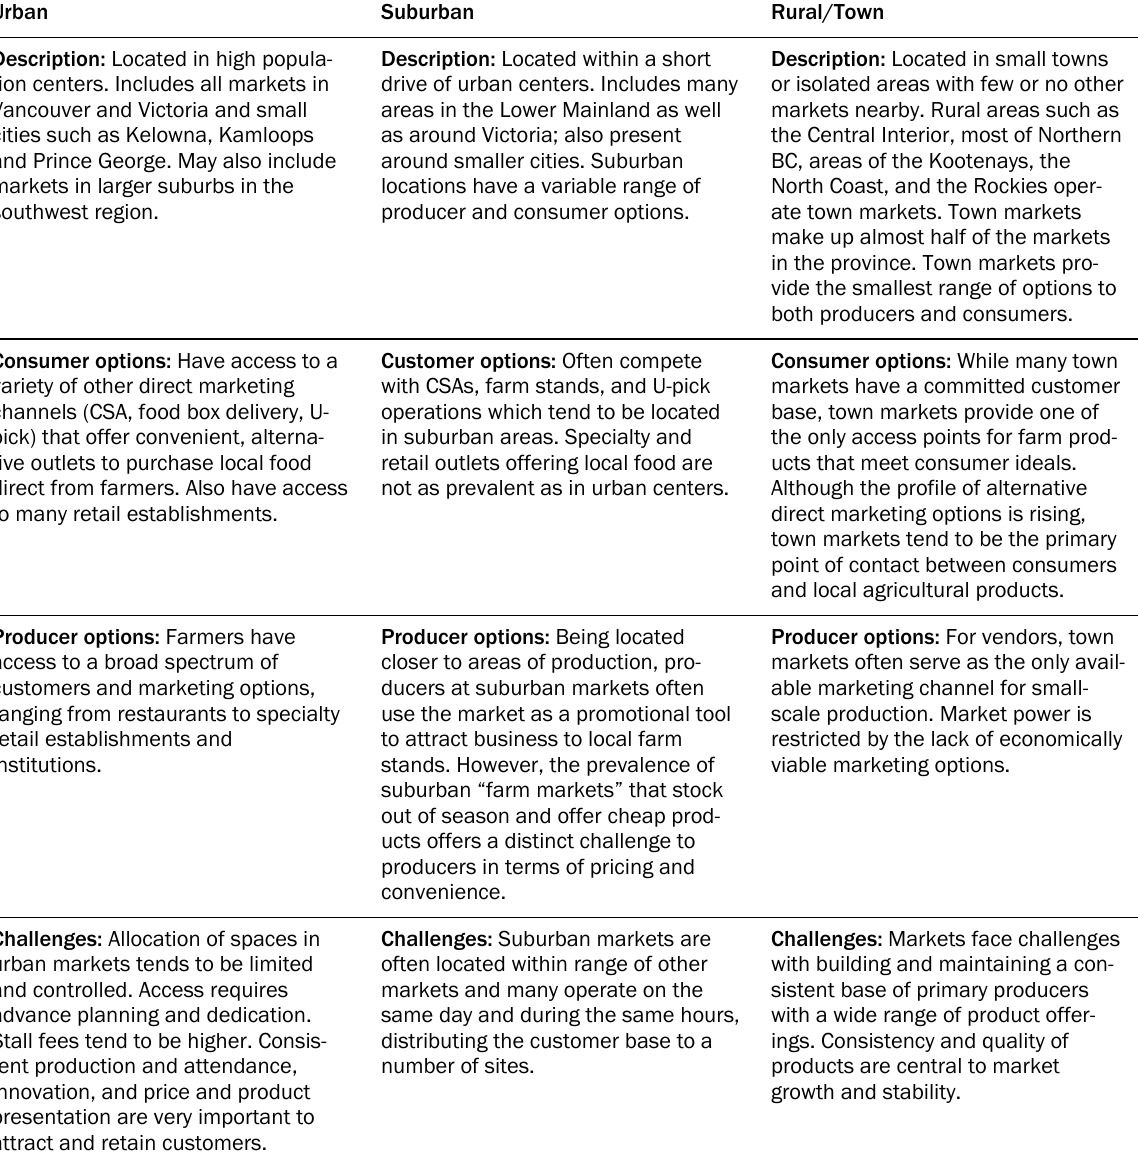
Table 1. Characteristics of Farmers Markets by